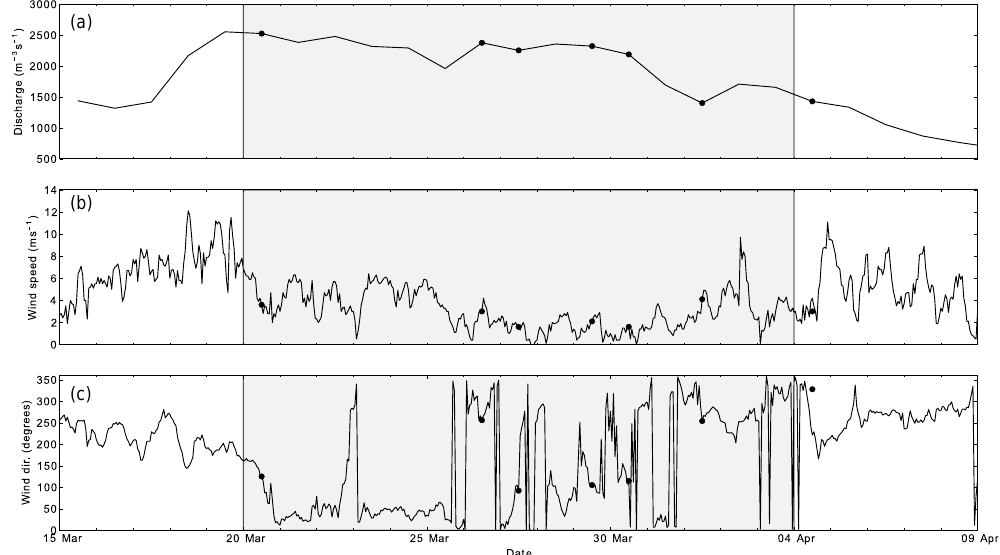
Figure 2. Time series of daily mean Daugava River discharge (a) , hourly wind speed (b) and wind direction (c) measured at Ruhnu weather station. Black dots show time instants when satellite images were acquired. The grey area marks the period between the first and last available satellite image from the study period (20 March to 4